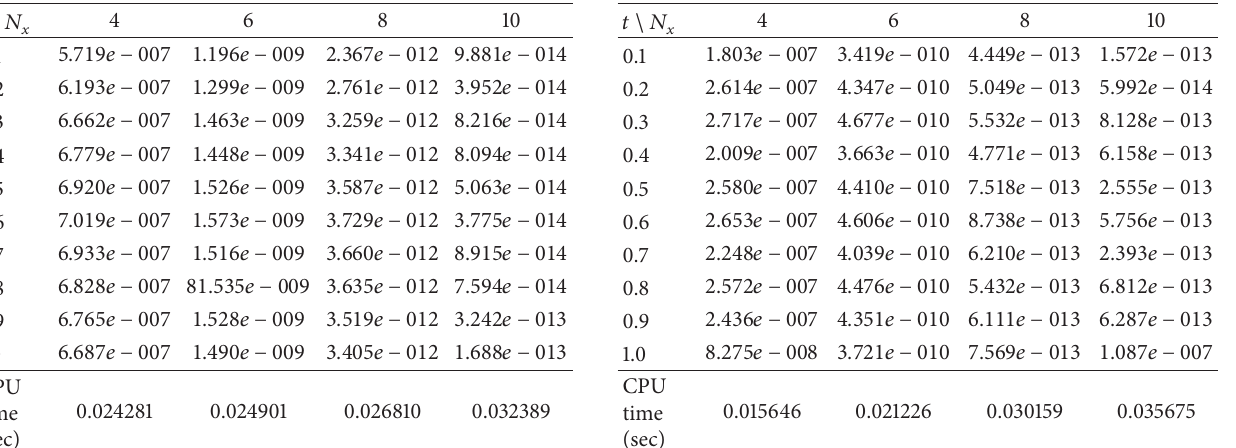
Table 3: Maximum errors 𝐸 𝑁 for the Fitzhug-Nagumo equation when 𝛼 = 1 using 𝑁 𝑡 = 10 .